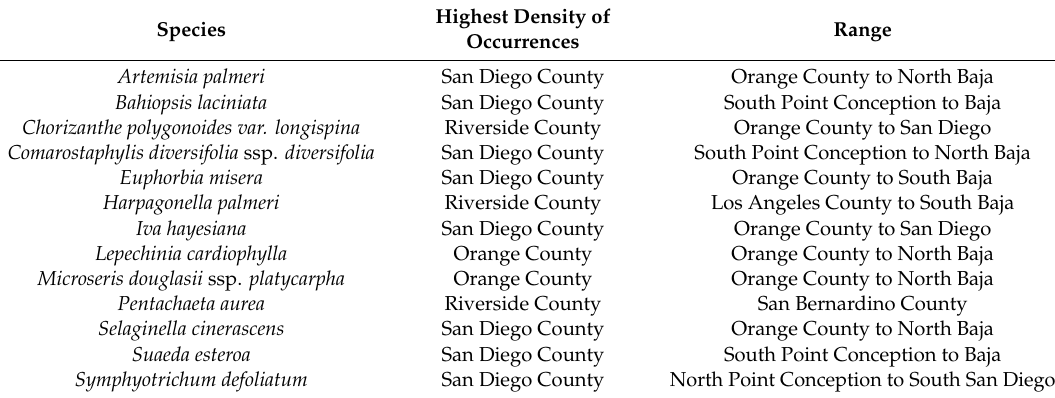
Table A1. Rare Species that occur within the Natural Communities Coalition (NCC) Reserve System and have their northern ranges extend into Orange County.